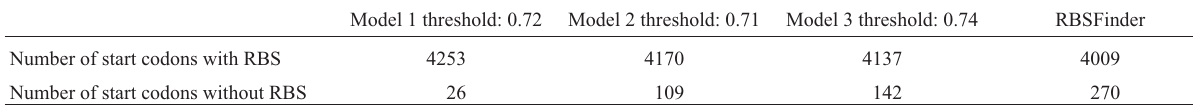
Table 9 - Number of RBS sequences predicted by the 3 models and the RBS